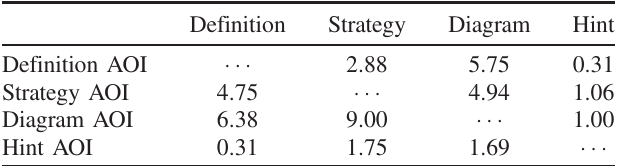
TABLE IV. Average number of transitions between individual elements of the instruction page. The upper (lower) diagonal refers to students instructed without (with) highlights.